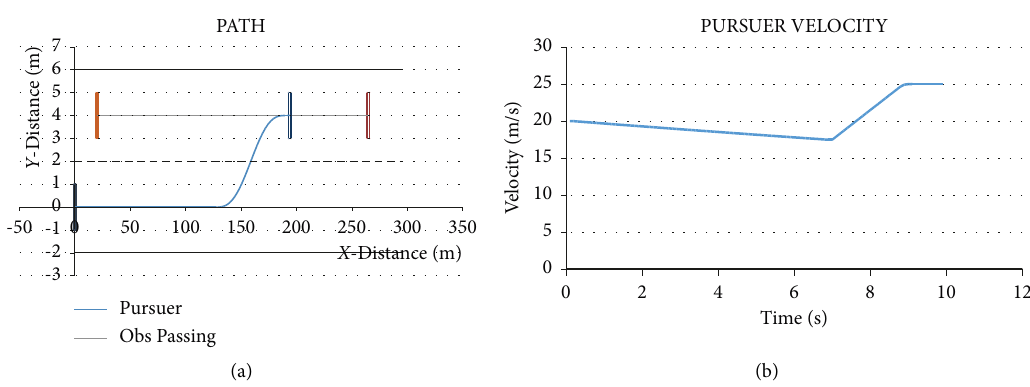
Figure 8: Joining highway with obstacle vehicle (plots for path and velocity of C